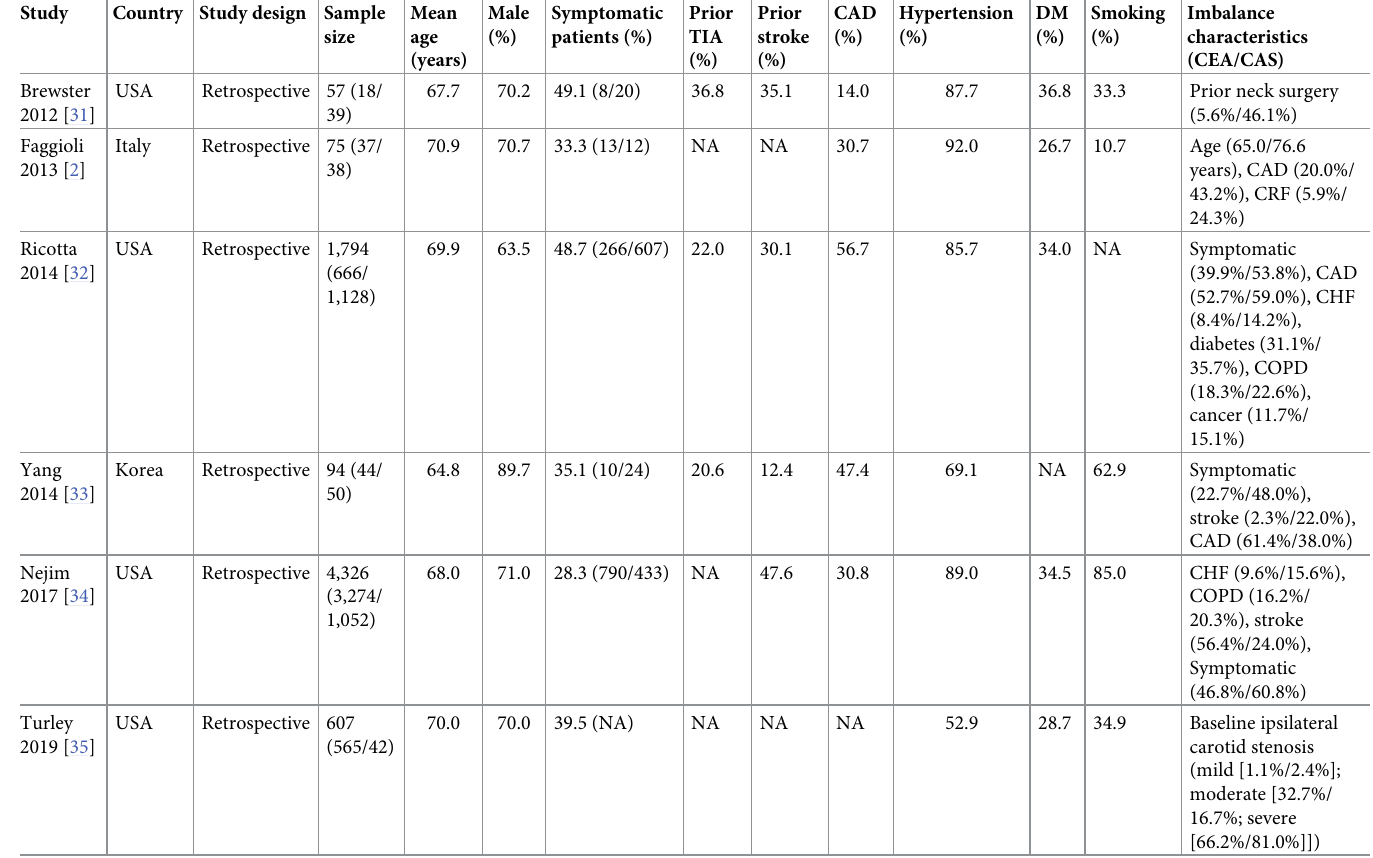
Table 1. Baseline characteristics of included studies and patients.